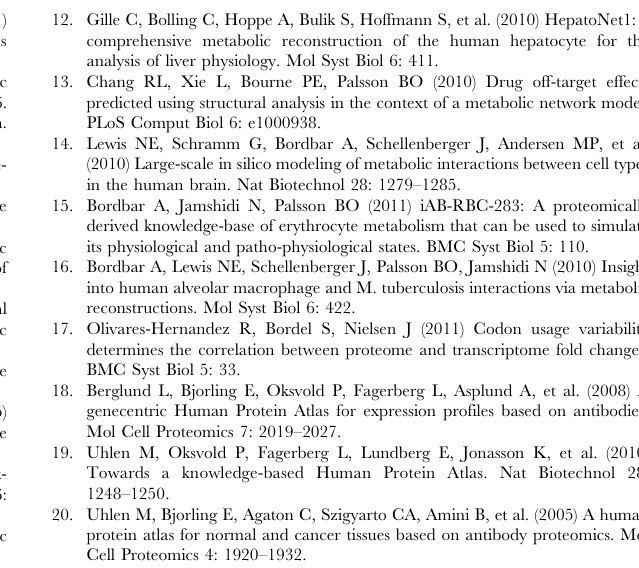
Table S3 Investigation of the 76 genes that were removed during the pre-processing steps. 76 genes which were present in both HepatoNet1 and the HMR database were removed in order to get a fully connected input network for the INIT algorithm. This table summarizes which genes were removed during each of the pre-processing steps (see Table S2 for details). Table S4 Investigation of the 105 genes which are present in HepatoNet1 but missing in iHepatocyte1154 due to the INIT algorithm. The 105 missing genes were associated with 182 reactions in HepatoNet1, of which 5 metabolic reactions are related to the sinusoidal space compartment. 108 metabolic reactions existed in iHepatocyte1154 with different gene or no gene association and 69 (60 unique) reactions are absent in iHepatocyte1154 due to INIT algorithm. KEGG reaction identifiers are provided for the missing associated reactions to the genes. Table S5 List of reactions that were significantly more present in cancer tissues compared to their correspond- ing normal tissues (p-value , 10e-4). Table S6 List of genes for which their corresponding reactions were significantly more present in cancer tissues compared to their corresponding normal tissues (p-value , 10e-4). Table S7 List of Reporter Metabolites (p-value , 10e-4). Table S8 Versions of the databases used in the creation of the Human Metabolic Reaction database (HMR). Table S9 Number of the genes after each pre-process- ing step during the generation of iHuman1512 . Since the